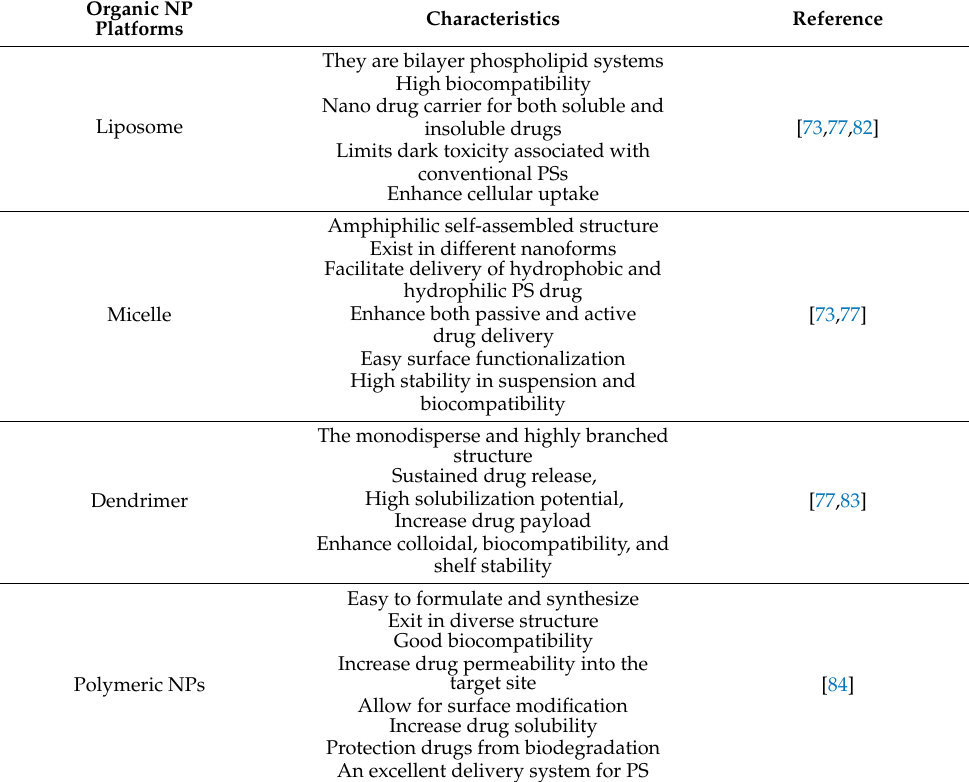
Table 1. Organic NP platforms and characteristics applied for targeted PDD and